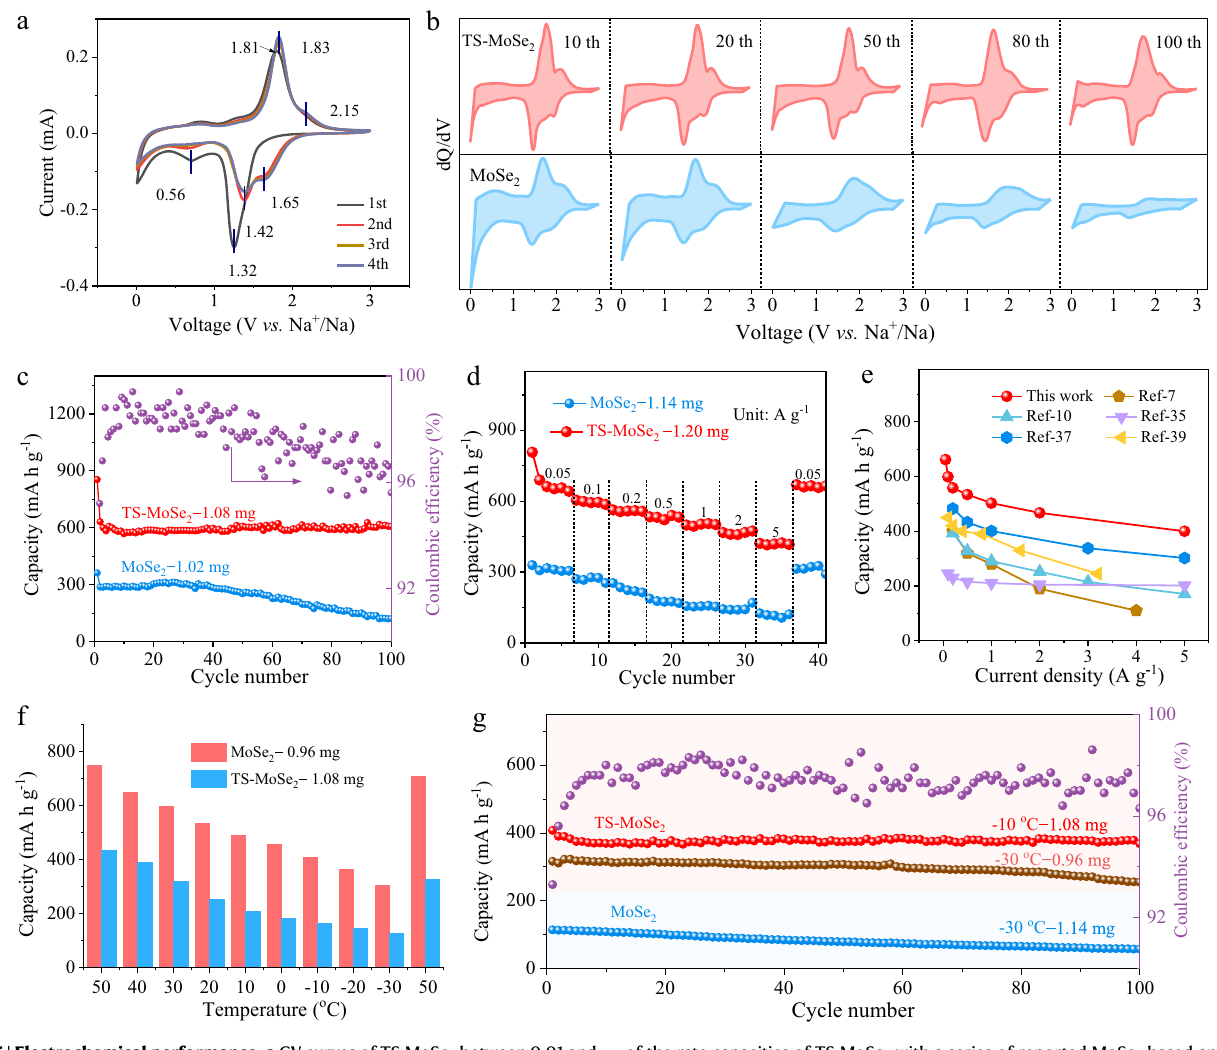
of the rate capacities of TS-MoSe 2 with a series of reported MoSe 2 -based anodes. f Cycling performances of TS-MoSe 2 and MoSe 2 atdifferent temperatures from 50 to − 30°C. g CyclingperformancesofTS-MoSe 2 at − 10, − 30°CandMoSe 2 at −